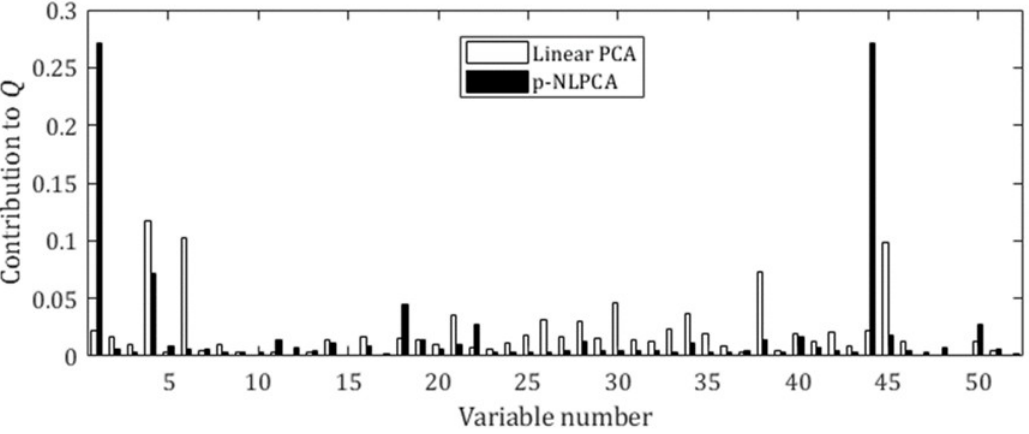
Figure 6. Contribution plots of Q statistics for Fault 1.